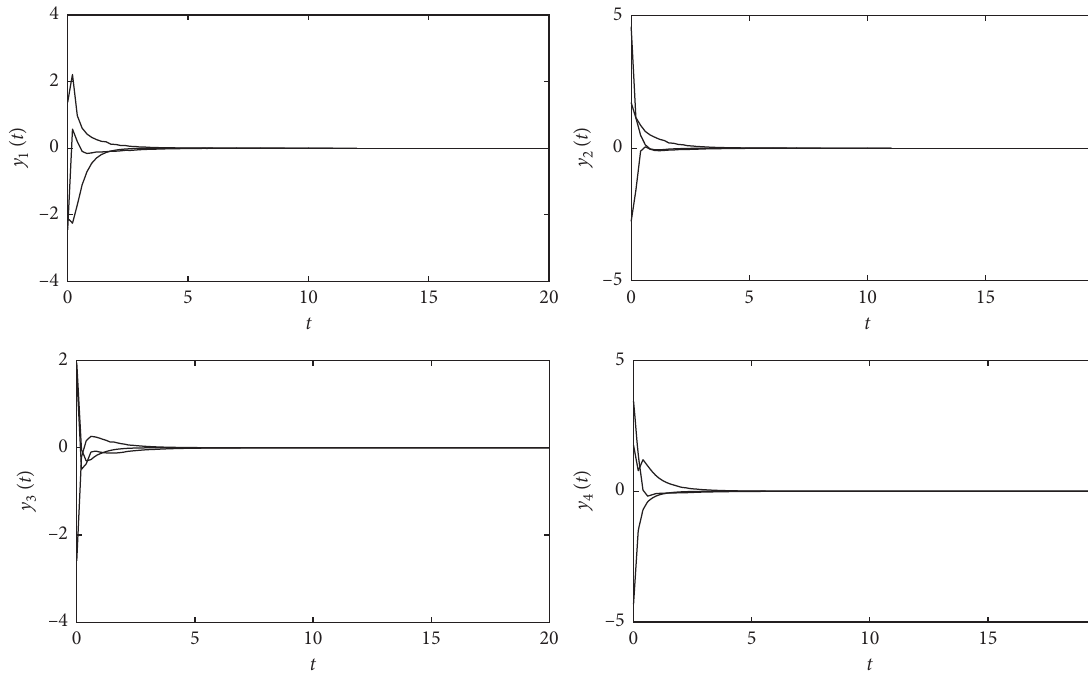
Figure 2: All the trajectories of the error systems y